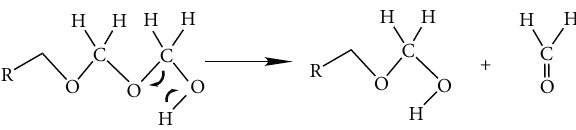
Scheme 3: The depolymerization mechanism of HOPOM.